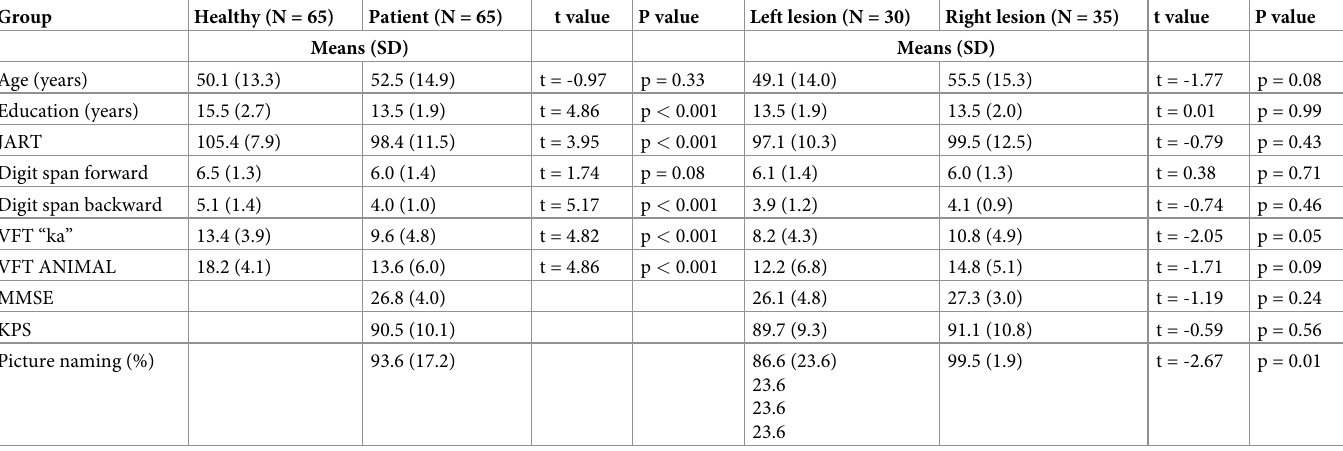
abuse. The demographic characteristics of the participants are presented in Table 1. This study Table 1. Means and standard deviations of